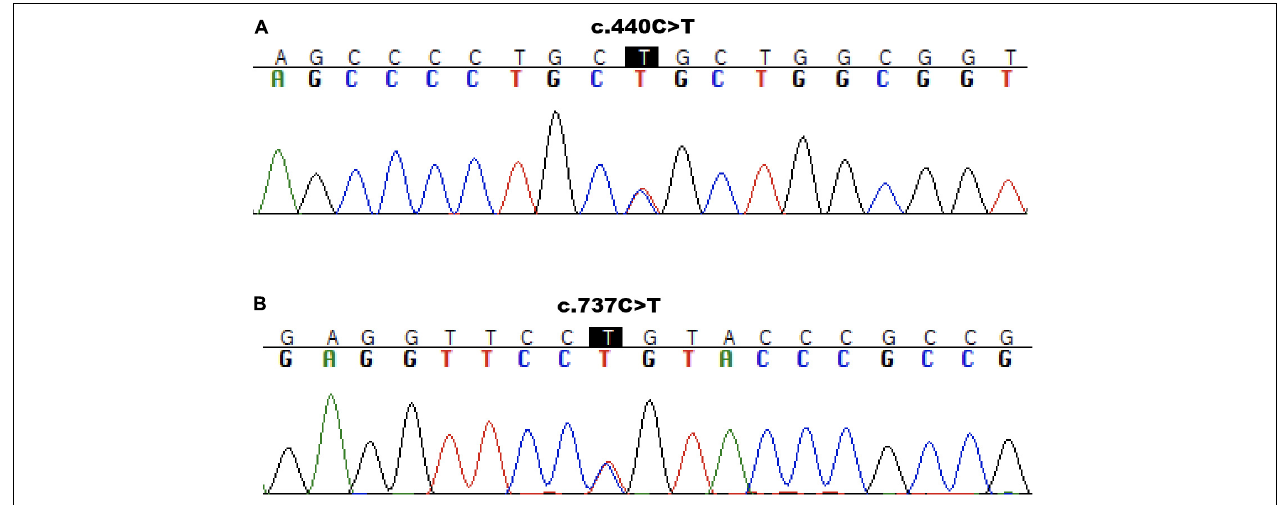
FIGURE 2 | Sanger sequencing results. Molecular analysis presenting ABCA3 variant c.440C > T/p.Pro147Leu to be inherited from mother (A) and variant c.737C > T/p.Pro246Leu from father (B) .